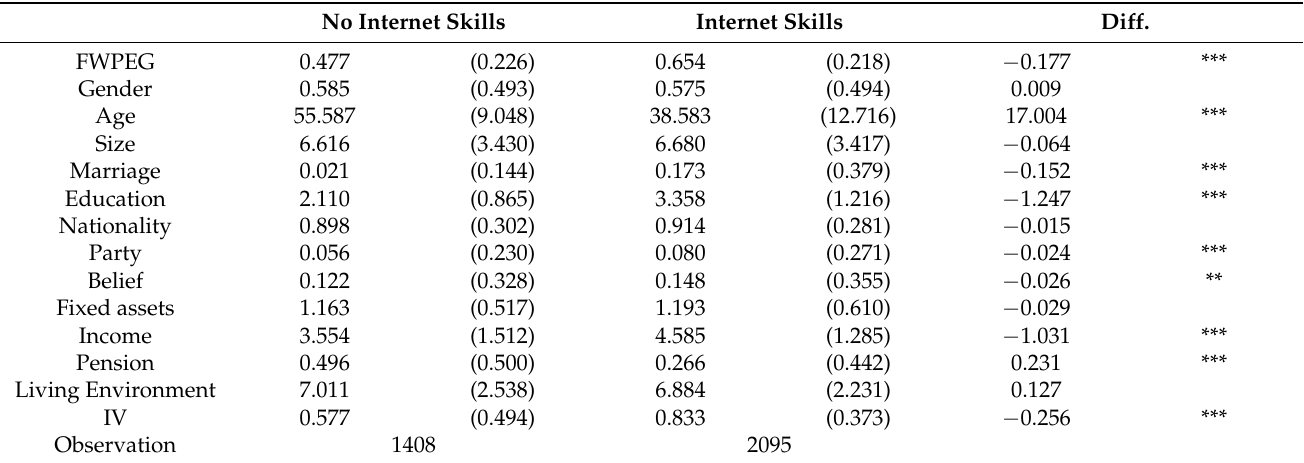
Table 4. Mean differences in variables